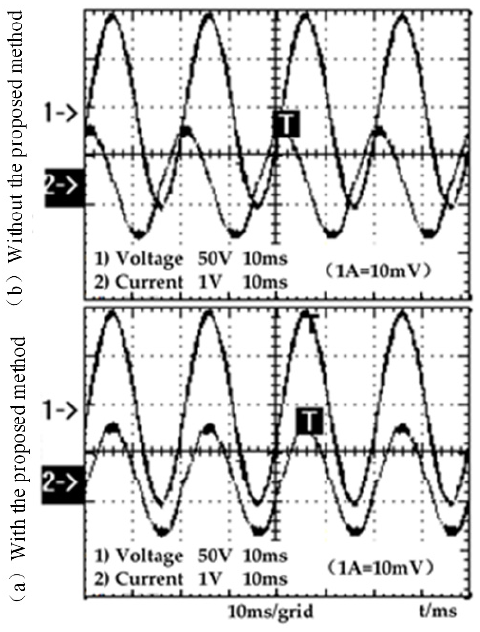
Figure 12. SVG Waveforms of U–I relation before and after compensation (resistive-capacitive load).